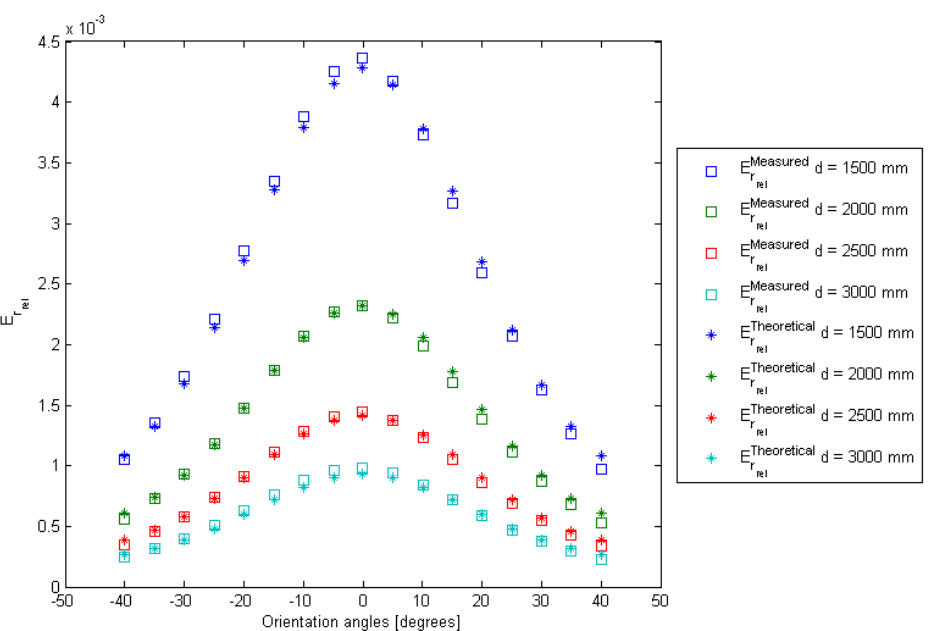
Figure 4. Relative accumulated image irradiance model fitting taking into account the IRED orientation